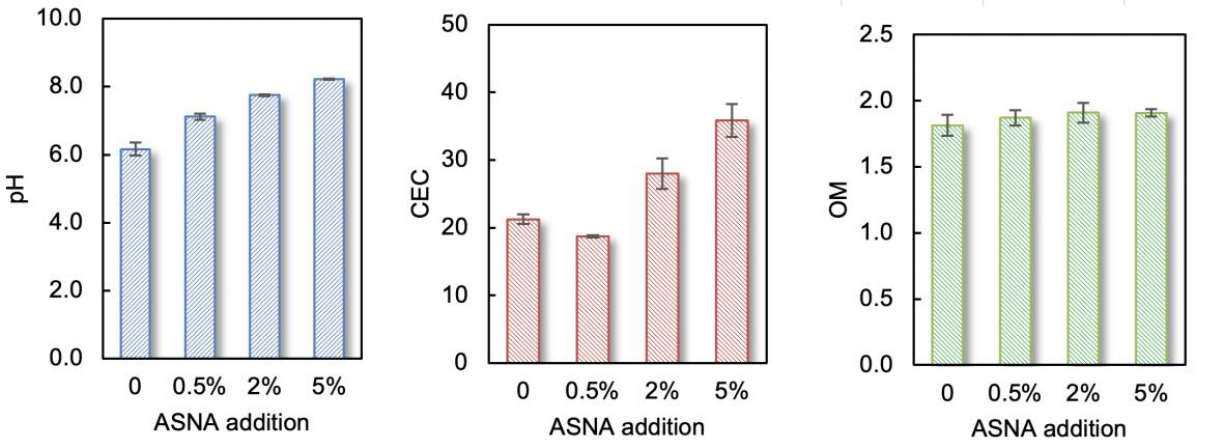
Figure 3. Effects of ASNA on soil pH, CEC, and OM.